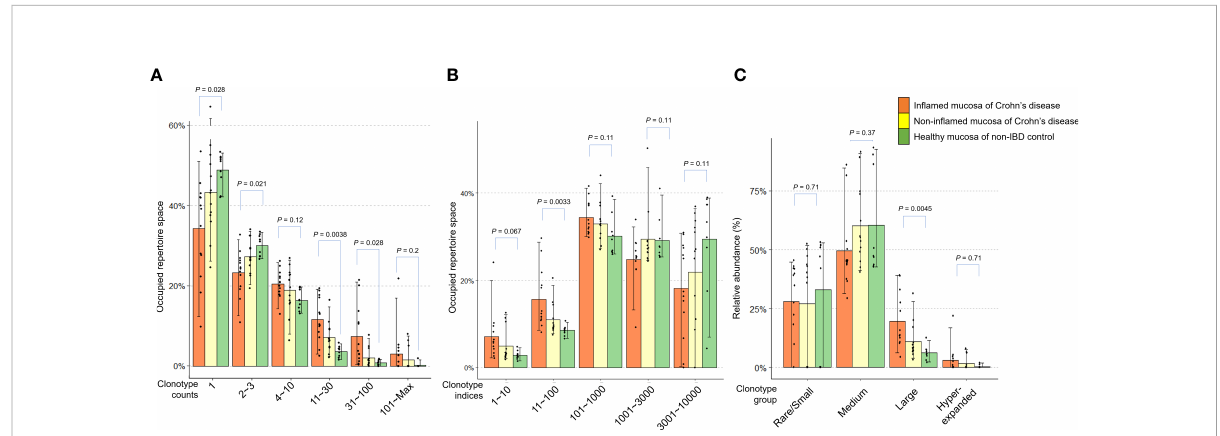
FIGURE 3 Distribution of clonotypes occupying TCR repertoires in in fl amed and non-in fl amed mucosa of patients with Crohn ’ s disease and healthy mucosa of non-IBD controls. (A) Proportion of TCR repertoire occupied according to clonotype counts. (B) Proportion of TCR repertoire occupied according to clonotype indices. (C) Relative abundance of rare/small, medium, large, and hyperexpanded